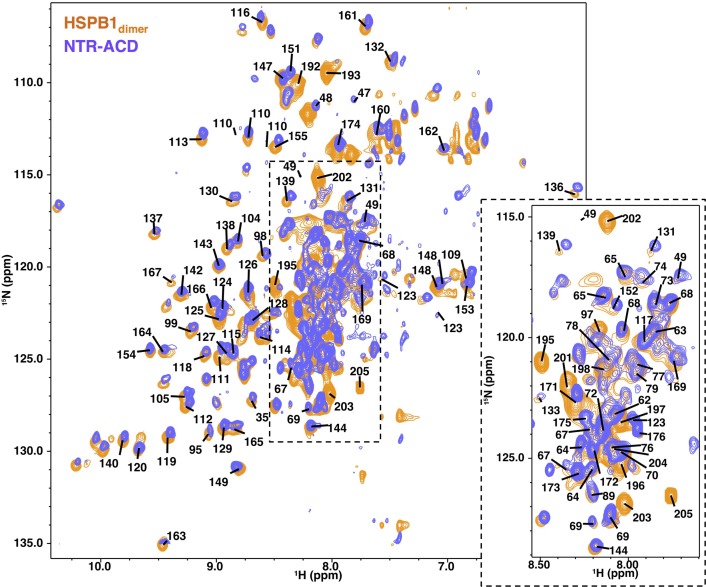
NMR spectra comparison of HSPB1dimer and NTR-ACD.1H-15N HSQC-TROSY spectra of the two constructs, showing considerable overlap; strong peaks in the center of the spectrum correspond to disordered regions of the protein (NTR and CTR). Center peaks are omitted for clarity and can be seen in the zoomed panel, which is at a higher noise level to better separate strong peaks.